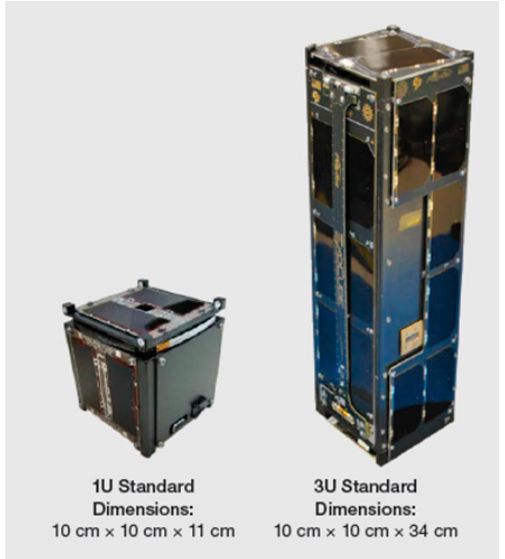
Figure 4. 1U and 3U CubeSat developed by CalPoly [24].